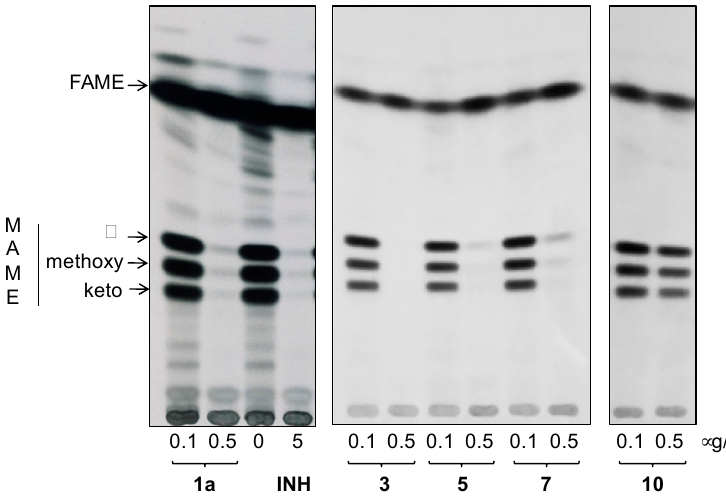
Figure 7. TLC analysis of methyl esters of fatty (FAME) and mycolic (MAME) acids isolated from 14 C acetate labeled M.tb H37Ra cells treated with compounds 1a , 3 , 5 , 7 and 10 , INH and DMSO as a control. Different forms of methyl esters were separated in n -hexane:ethyl acetate (95:5; 3×) and detected by autoradiography. ( , methoxy, and keto refer to forms of MAMEs).